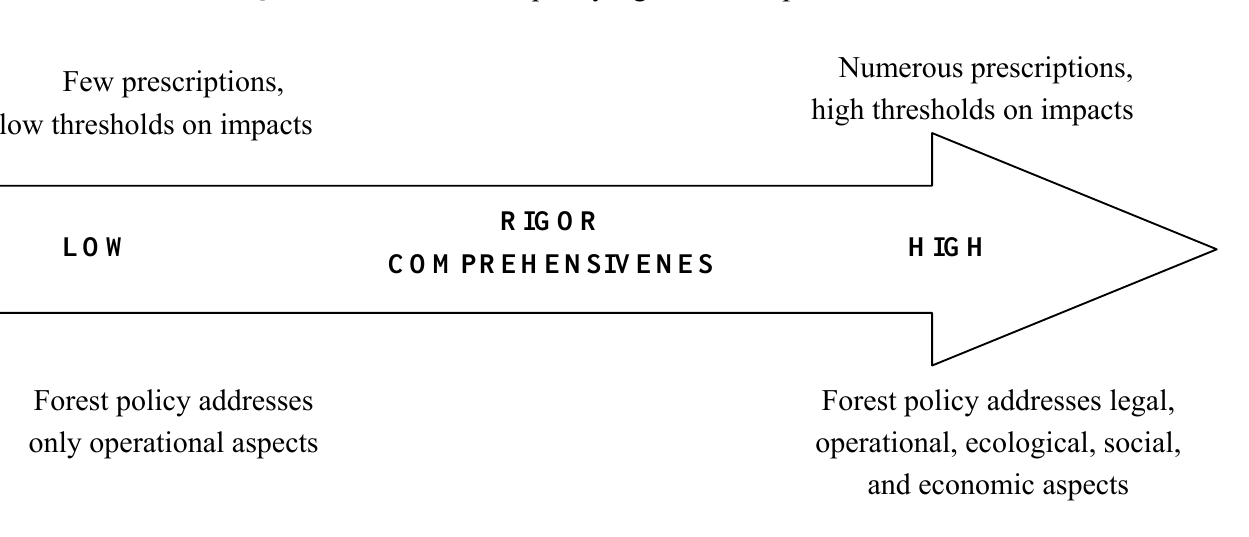
Figure 2. Scale of forest policy rigor and